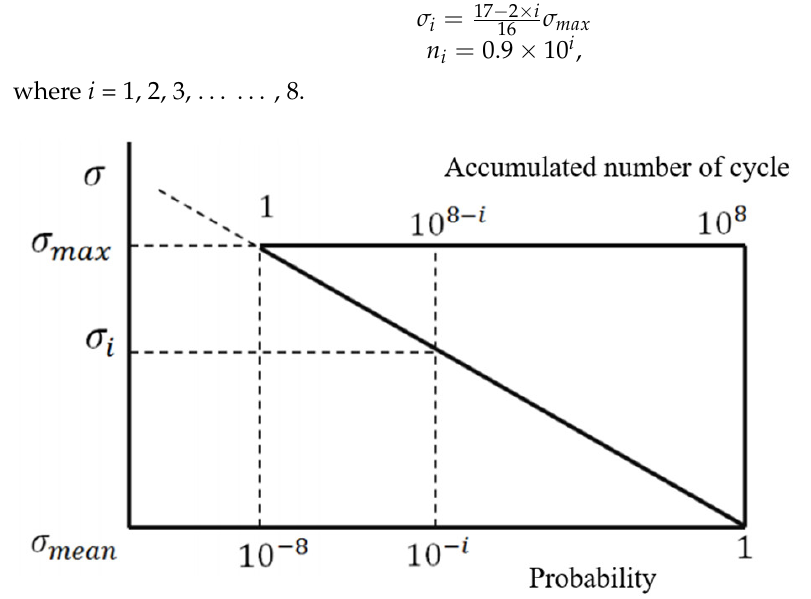
Figure 17. Calculation of fatigue stress and number of cycles